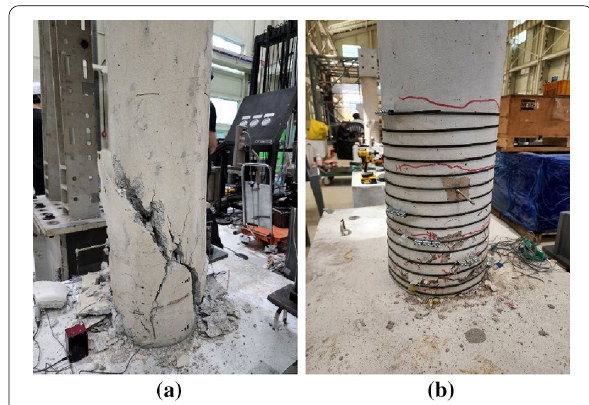
Fig. 13 External damages of concrete columns: a Control; b Fe-SMA